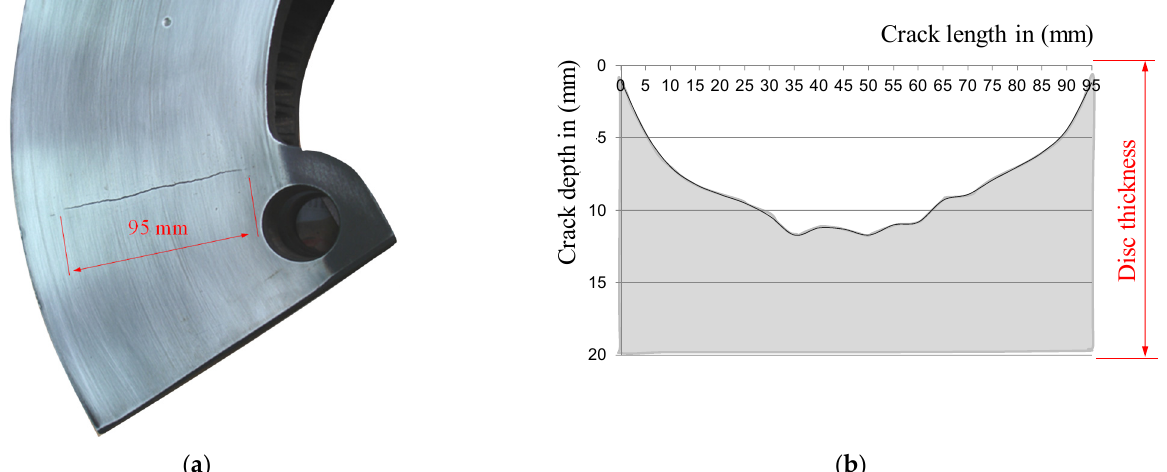
Figure 10. One-sided crack on the ring of the railway brake disc: ( a ) view of the crack and ( b ) the relationship between the length of the crack and its depth, measured with the RMG 4015 device.